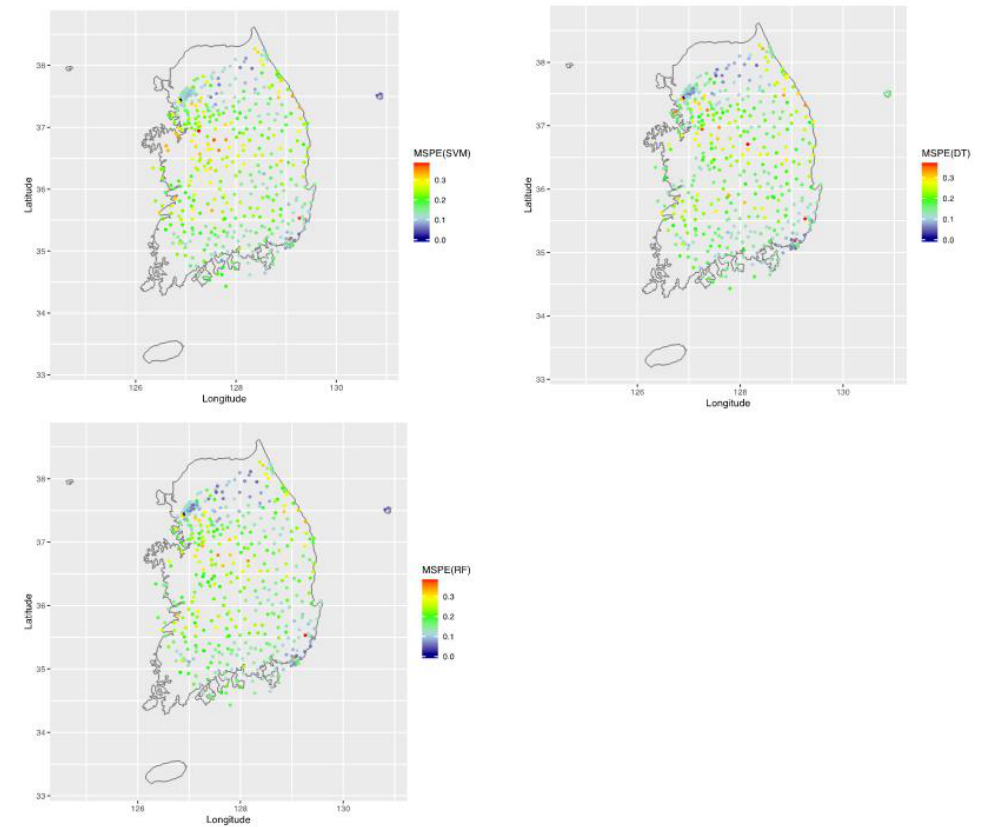
Figure 8. Spatial distributions of the MSPE for